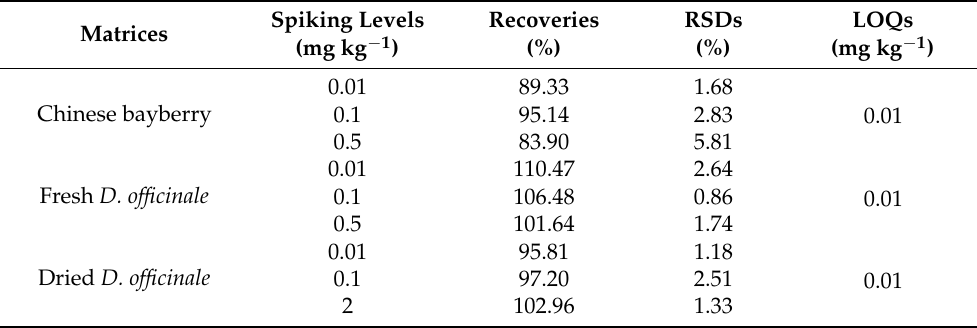
Table 2. The average recoveries, relative standard deviations (RSDs), and limit of quantitations (LOQs) of metalaxyl in Chinese bayberry and D. officinale .